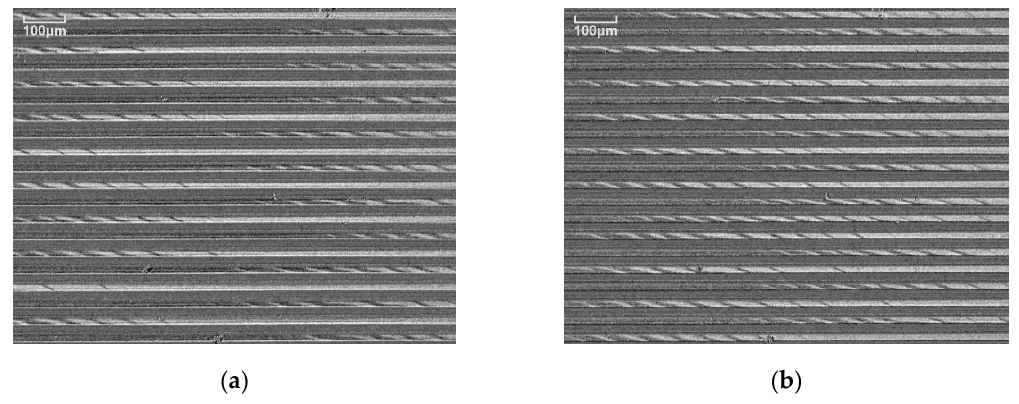
Figure 16. Magnetic domain with applying distributed field ( θ = 71 ◦ ). ( a ) Distributed parameter ∆ B x / ∆ x = 0.54 (T/m). ( b ) Distributed parameter ∆ B x / ∆ x = 1.22 (T/m).